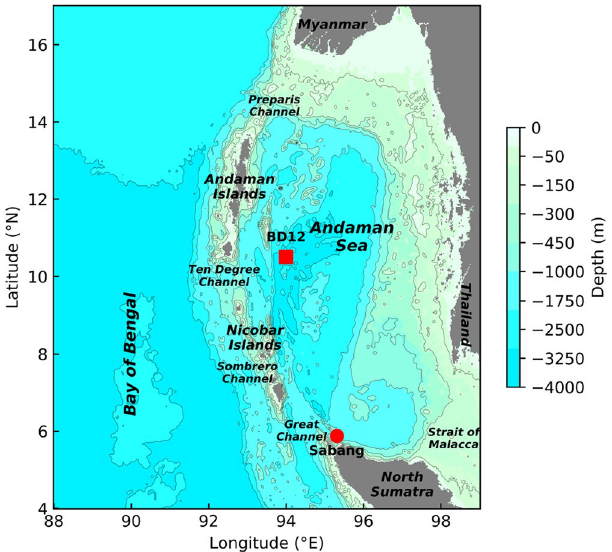
Figure 1. Model domain for the Andaman Sea along with the locations of BD12 and tide-gauge at Sabang. Bathymetry is derived from GEBCO. The relevant copyright information can be found at https:// www. gebco. net/ data_ and_ produ cts/ gridd ed_ bathy metry_ data/ gebco_ 2019/ grid_ terms_ of_ use.